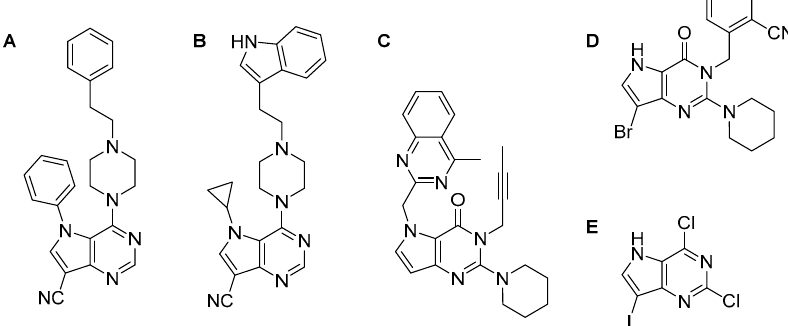
Figure 2. Structures of active pyrrolo[3,2- d ]pyrimidines. ( A and B ) Inhibitors of multidrug resistance protein 1 (MRP1), P-glycoprotein, and breast cancer resistance protein (BCRP). ( C and D ) Inhibitors of dipeptidyl peptidase IV (DPP-IV). ( E ) Broad-spectrum antiproliferative agent, with potent activity against MIA PaCa-2 pancreatic cells.